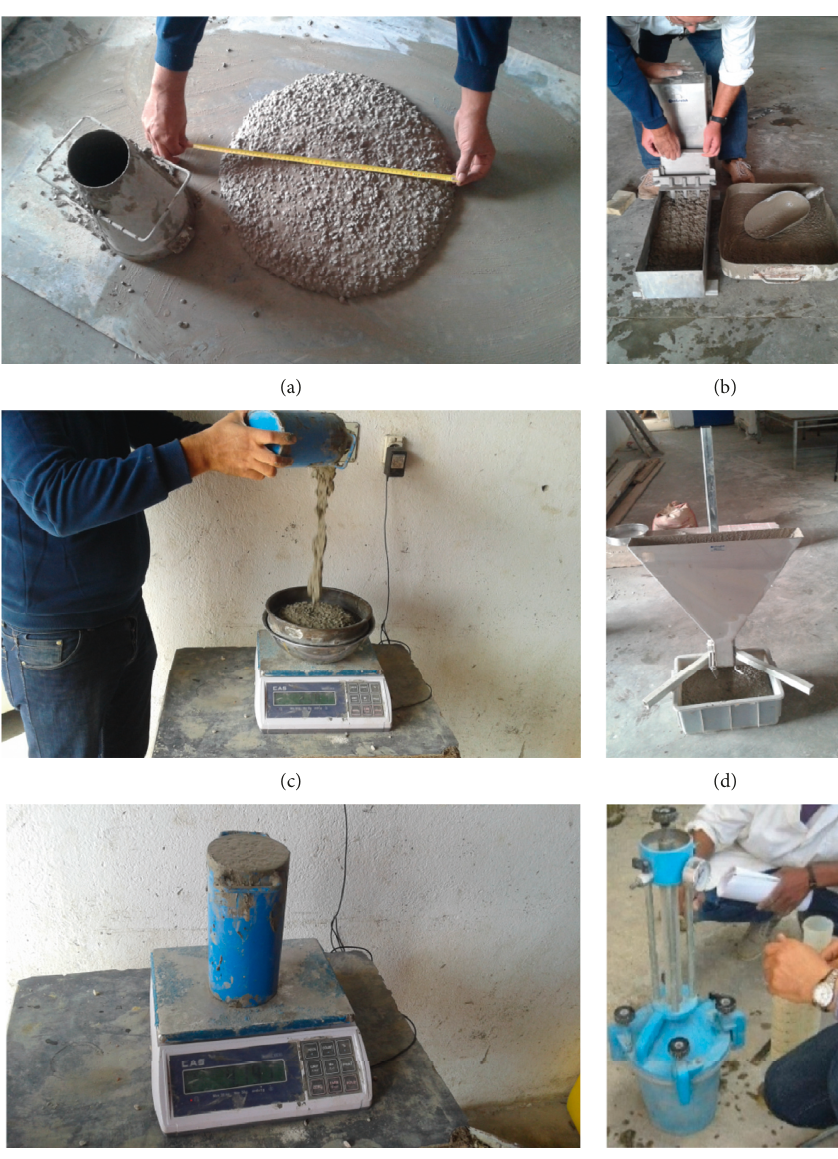
Figure 3: Test on the four SCCs in the fresh state. (a) Slump flow test. (b) L-box test. (c) Sieve stability test. (d) V-funnel test. (e) Bulk density. (f) Air content